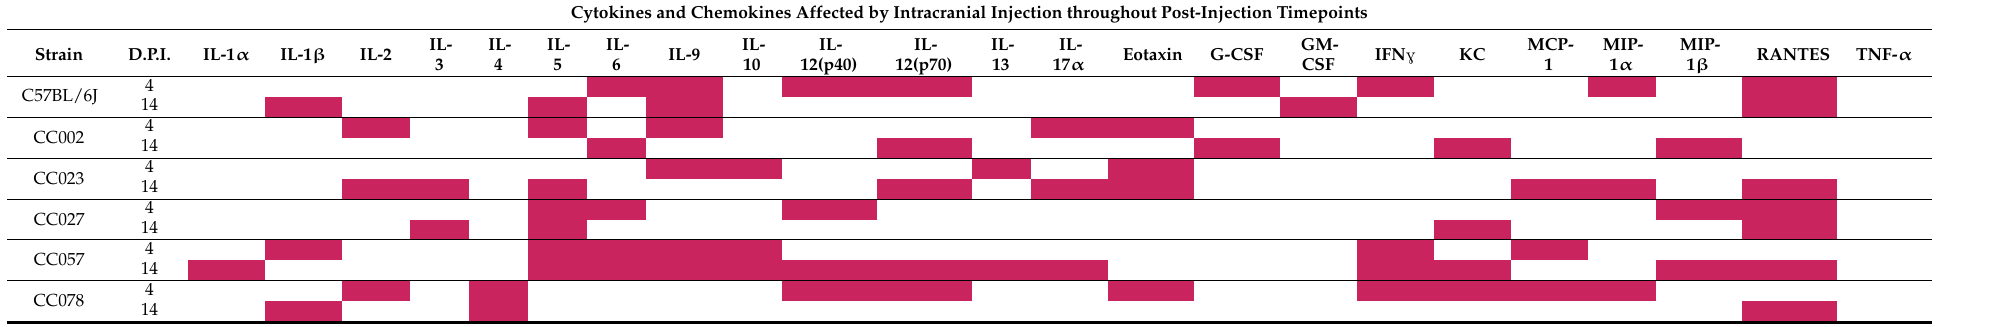
Table 2. Highlighted are cytokines and chemokines produced in response to the i.c. injection. We summarized the cytokine and chemokine responses induced by the injection procedure, identified via paired difference analysis between pre-injection and post-injection (4 and 14 d.p.i.) levels, as described in Figure 2A. The immune responses to the injection varied by mouse strain at each time point. Individual changes to each exposure group can be found in Supplementary Table